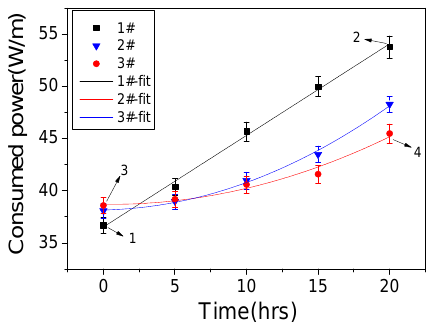
Figure 4. Consumed power of the three plasma devices as a function of the aging time.